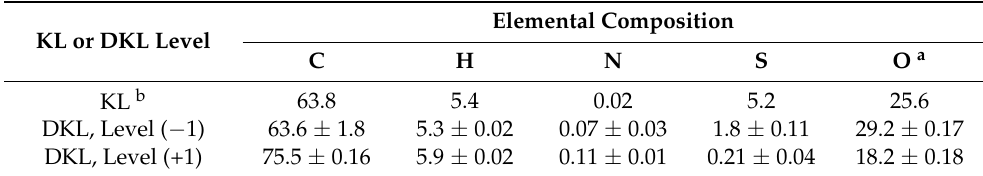
Table 2. Elemental compositions of KL and DKL products obtained from hydrolytic depolymerization reactions at various severities corresponding to different levels ( − 1 and +1) of M w .